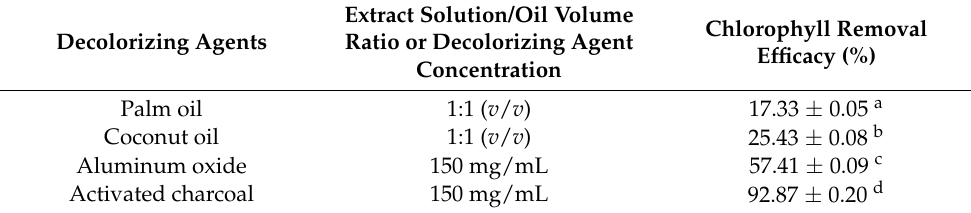
Table 10. Decolorizing agents and their chlorophyll removal